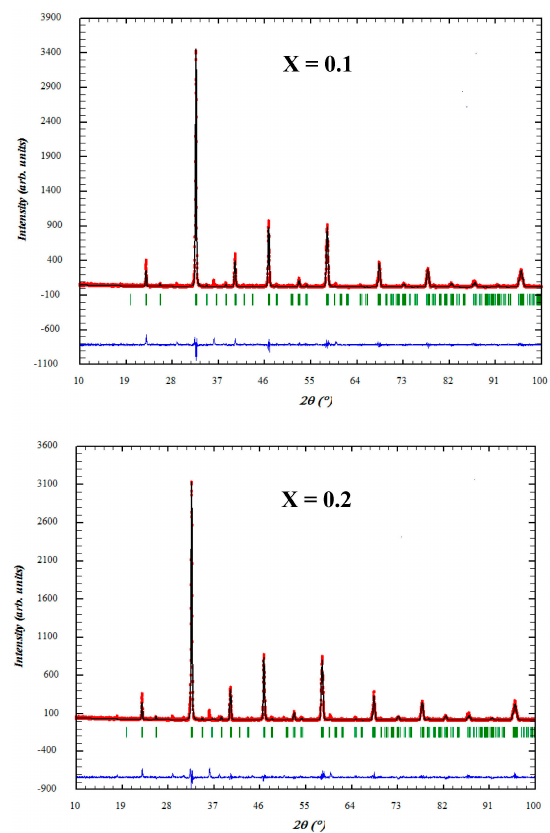
Figure 1. Observed (open symbols) and calculated (solid lines) X-ray diffraction pattern for La 0.8 − x (cid:0) x Ca 0.2 MnO 3 ( x = 0, 0.1 and 0.2) annealed at 973 K (S2). Positions for the Bragg reflection are marked by vertical bars. Differences between the observed and the calculated intensities are shown at the bottom of the diagram.